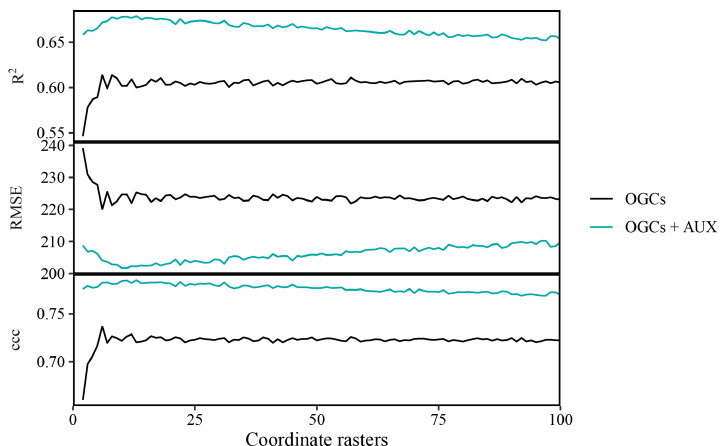
Figure A1. Accuracy of predictions on the meuse dataset (zinc contents) versus the number of coordinate rasters with oblique geographic coordinates, with and without auxiliary data. The values are averages obtained with 100 splits into training and test data.